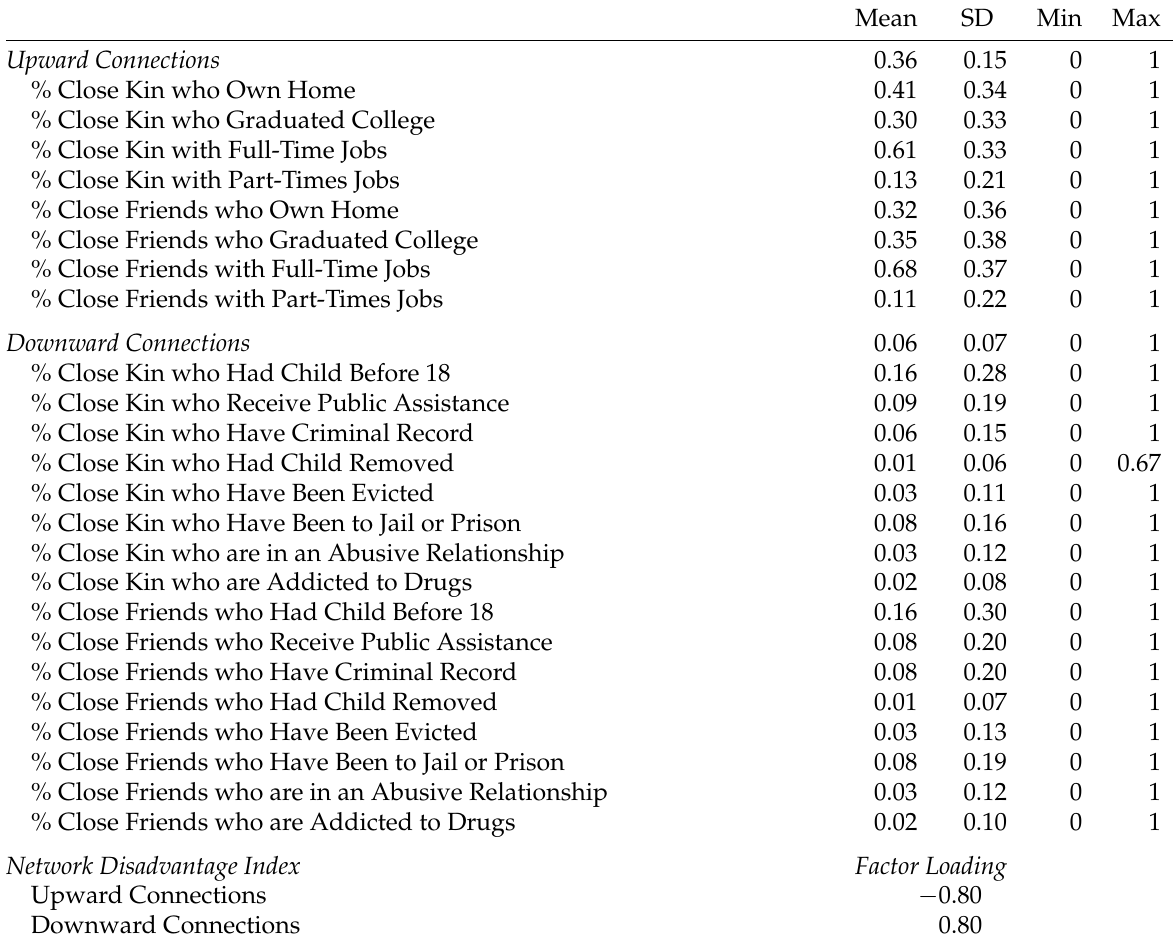
Mean SD Min Max